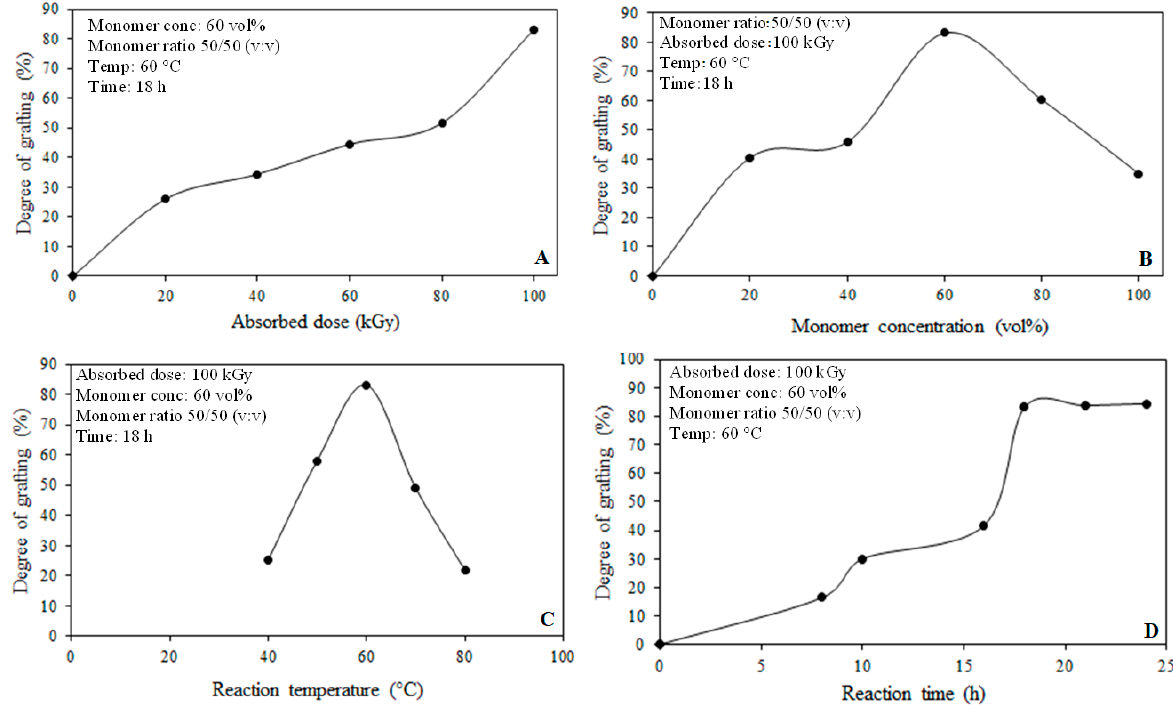
Figure 1. Variation of degree of grafting with reaction parameters: ( A ) absorbed dose, ( B ) monomer concentration, ( C ) reaction temperature, and ( D ) reaction time.